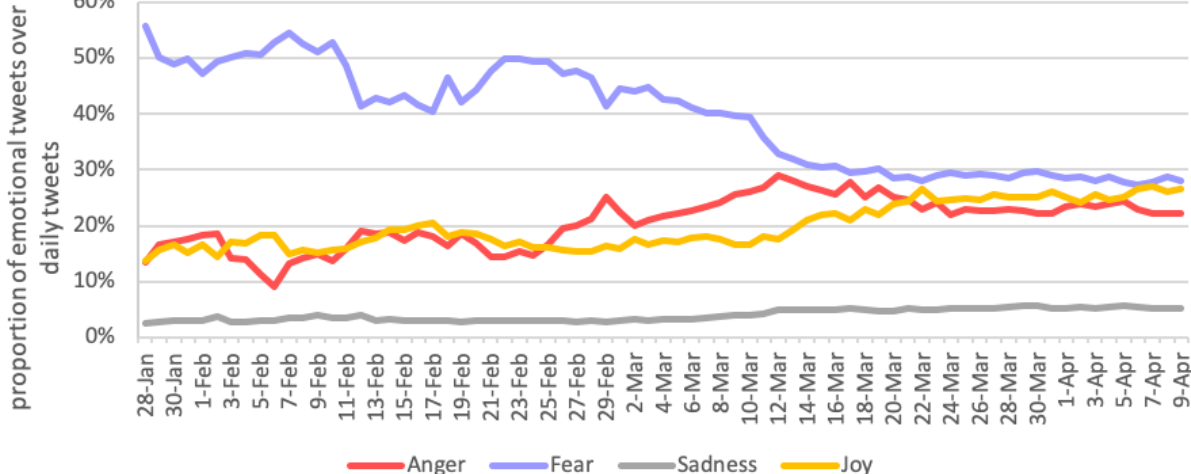
Expectedly, fear was the dominant emotion at the end of January when the disease first surfaced. The prominence of fear gradually dropped to less than 30% of daily tweets in early April as the crisis developed ( r =–0.92; P <.001). In contrast, tweets 71 on anger progressively increased from late January to early March, peaking at 29% on March 12, a day after the pandemic declaration by the WHO. Tweets on anger slightly decreased since then, but remains at a relatively high level ( r =0.75; 71 P <.001). Coinciding with the decrease of tweets on both fear and anger after the pandemic announcement, tweets on